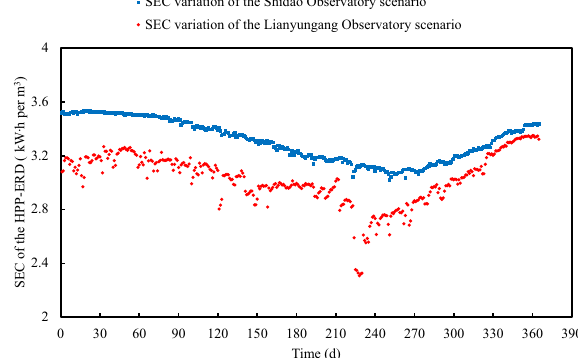
Fig. 3 Annual SEC variations of the HPP-ERD. Annual SEC variations of the HPP-ERD under the Shidao Observatory scenario and the Lianyungang Observatory scenario are